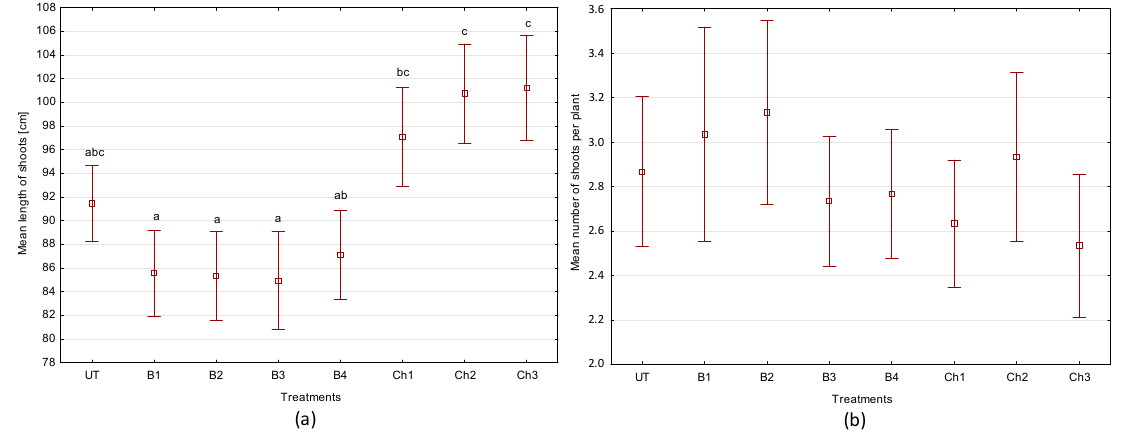
Figure 7. Length ( a ) and number of broad bean shoots ( b ) depending on the protection method used (mean in years 2010–2012): Treatments are the same as in Table 1. Vertical bars denote 0.95 confidence intervals. Means followed by the same letters are not significantly different according to the LSD test ( p < 0.05); in the case of number of shoots, means are not significantly different.